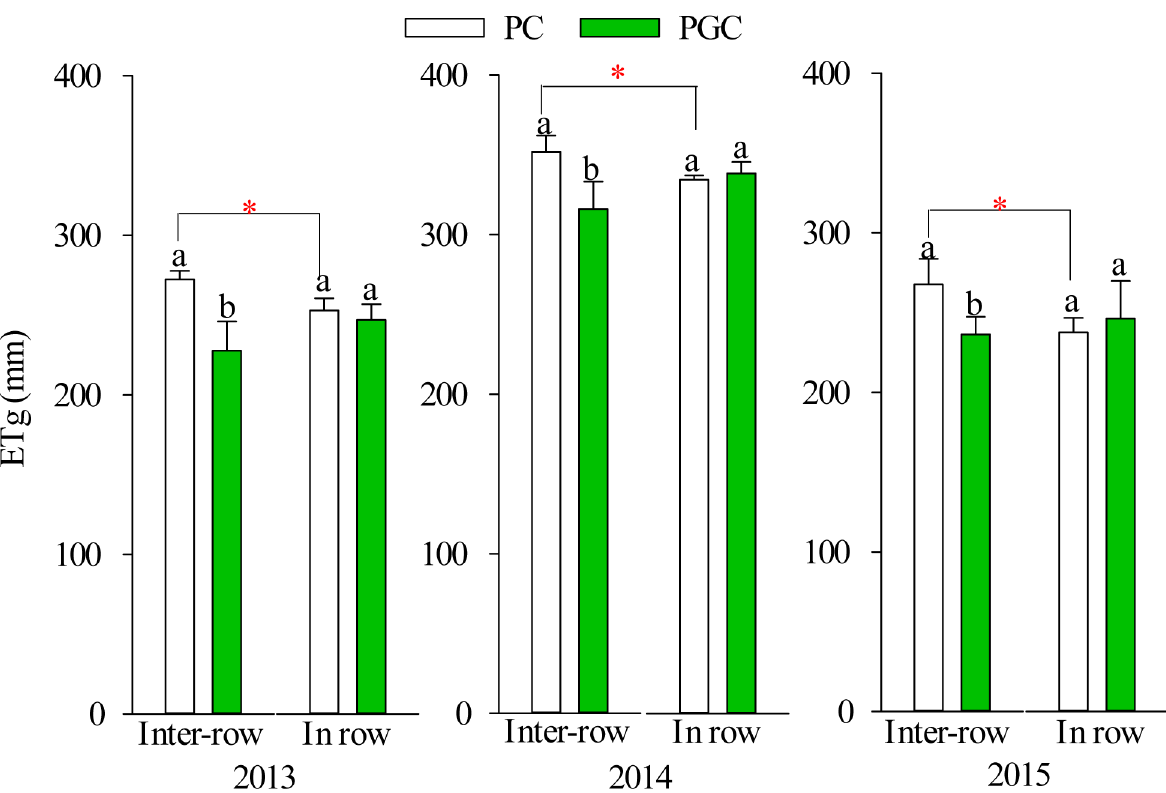
Fig 6. The evapotranspiration during the grass cover period (July-September) in 2013, 2014 and 2015. Lowercaseletters denote significantdifferences betweenPC and PGC for the inter-row or in-row ( p (cid:20) 0.05). “ * ” indicatesthat the differences betweenthe inter-row and in-row(connected by lines) of the PC or PGC treatment were significant( p (cid:20) 0.05). Error bars were the